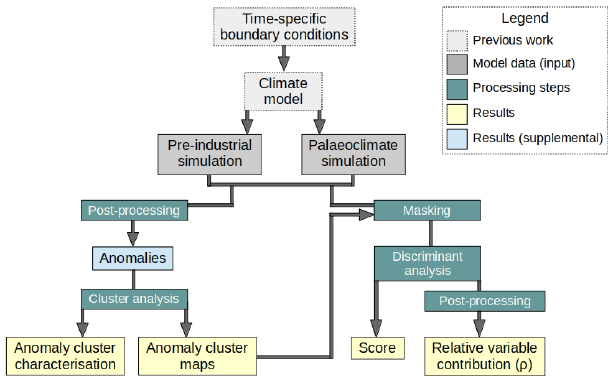
Figure 1. Anomalies are created from pre-industrial (PI) and Late Cenozoic palaeoclimates (MH, LGM, PLIO). These are subjected to geographical clustering, which results in the identification of dis- tinct modes of climate change (anomaly cluster characterisation) and maps showing the spatial extent of regions governed by these modes (anomaly cluster maps). These are used as geographical masks for palaeoclimate simulations. For each of these anomaly clusters, a discriminant analysis is conducted to quantify the dis- criminability in each cluster (score) and the relative contribution of each climatic variable to this